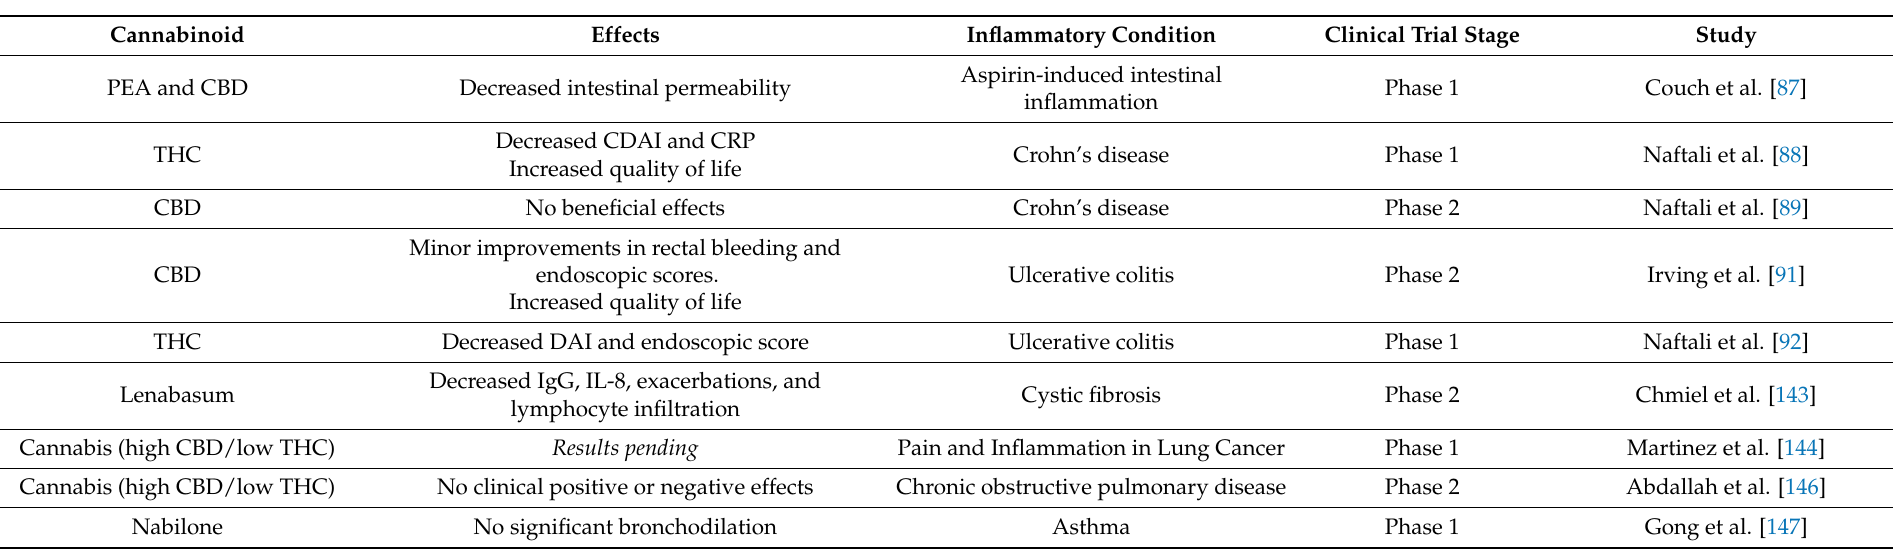
Table 3. Human trials evaluating the safety and efficacy of cannabinoids in inflammatory conditions of the gut-lung-skin